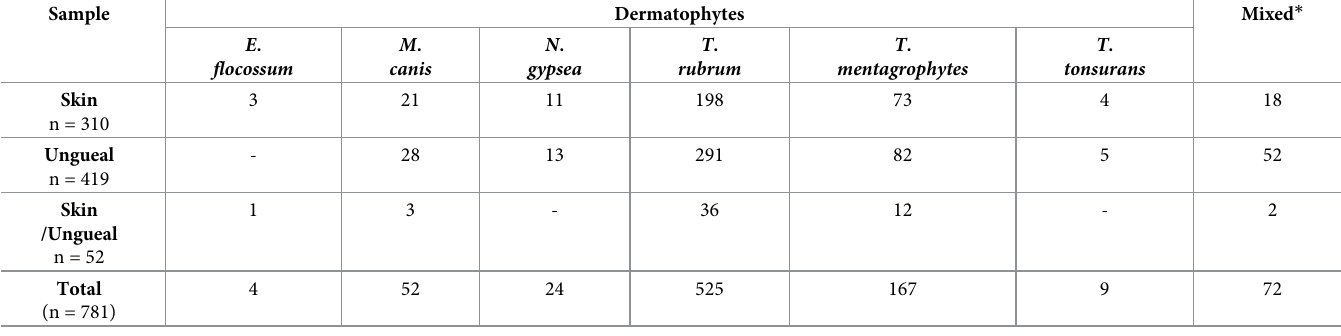
Table 2. Absolute number and distribution of dermatophytes species according to the anatomical site of the lesion. Sample